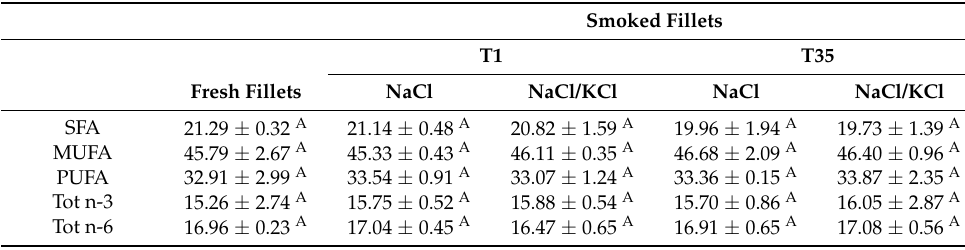
Table 3. Fatty acid composition in the fresh and smoked fillets of D. labrax at the beginning and at the end of storage time.